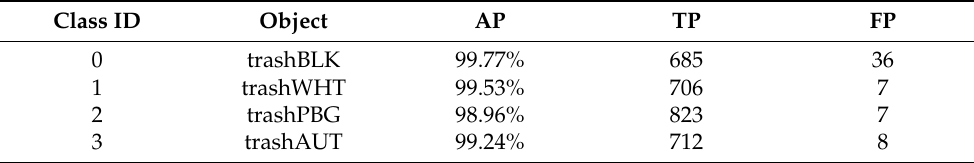
Table 1. Performance of identifying the four types of garbage bags using YOLOv4.